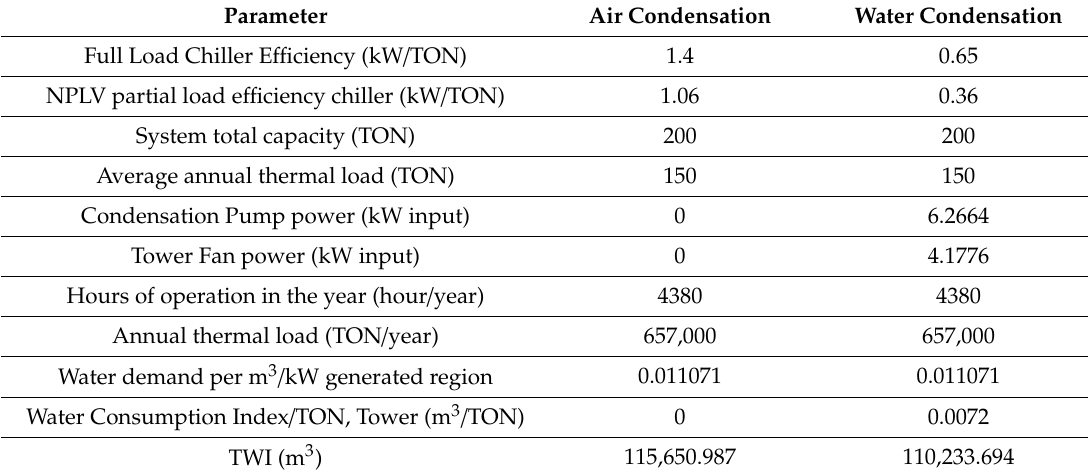
Table 1. 200 TON system